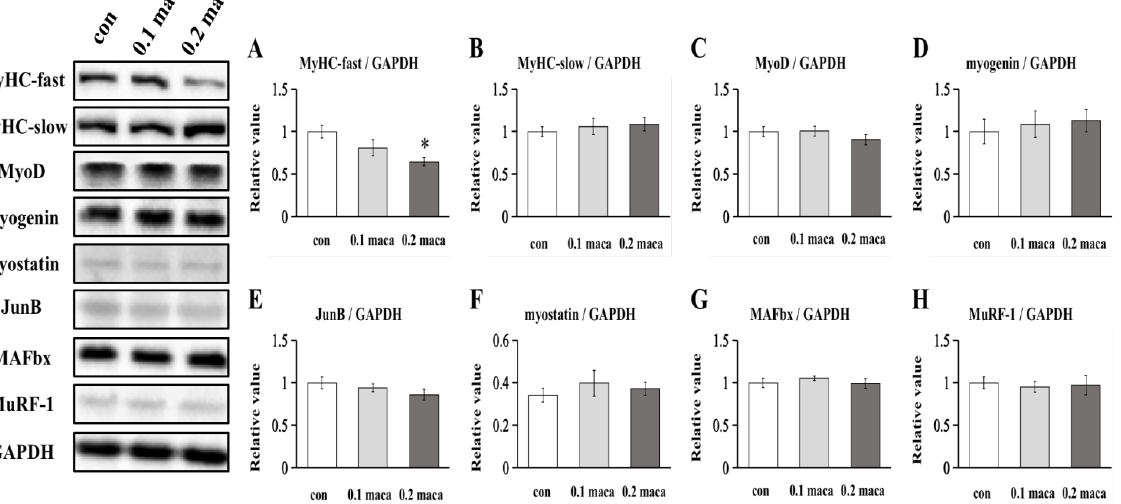
Figure 2. Expression of proteins in C2C12 myotubes. Representative immunoblots are shown on the left side, and the quantification of MyHC-fast ( A ), MyHC-slow ( B ), myogenin ( C ), MyoD ( D ), JunB ( E ), myostatin ( F ), MAFbx ( G ), and MuRF-1 ( H ) was determined after normalizing to GAPDH. * p < 0.05 vs. con.